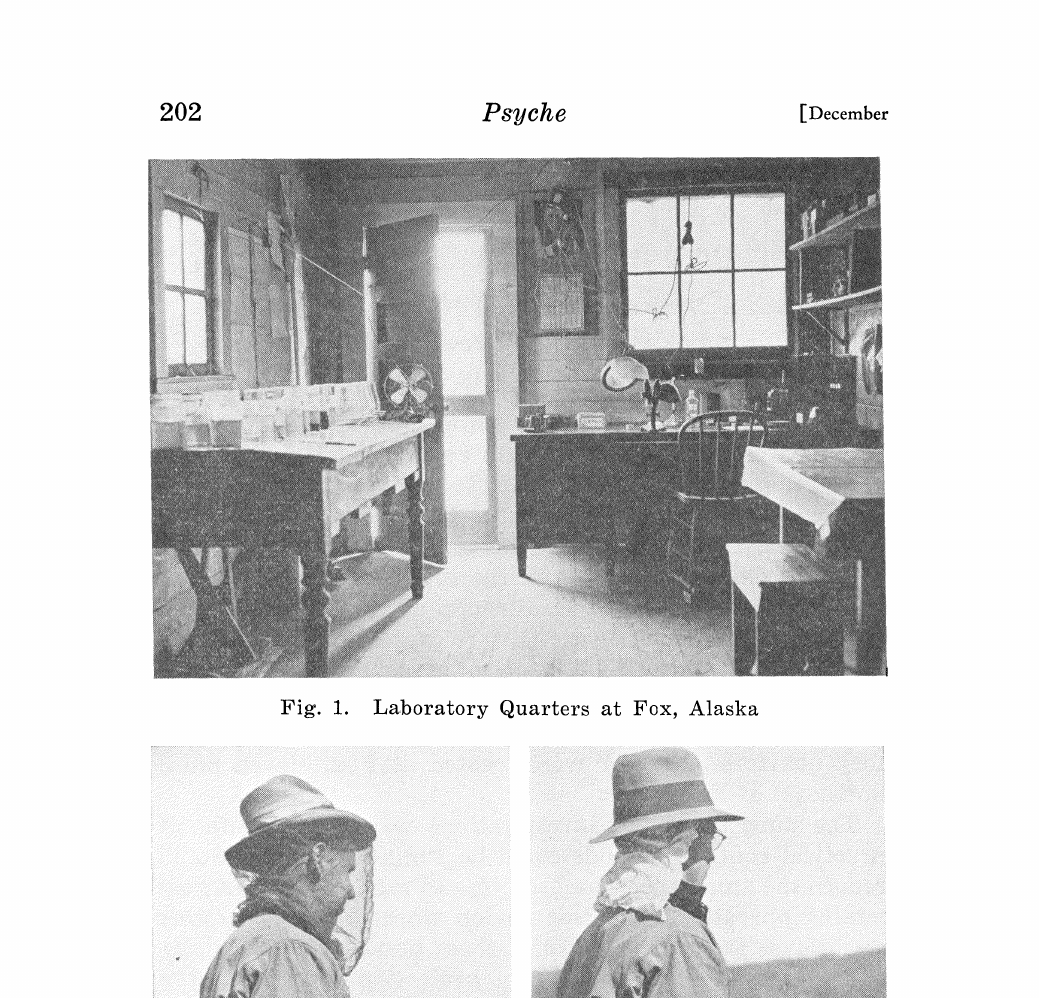
Fig. 2. Net used as protection Fig. 3. Use of gloves as protec- against mosquitoes tion against